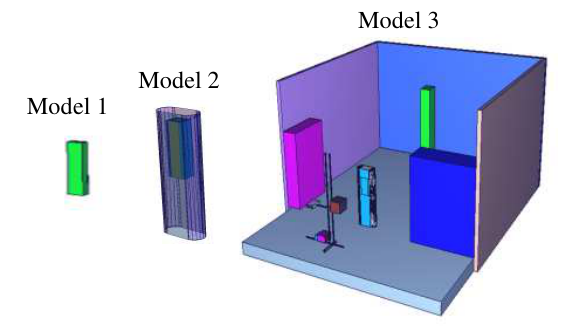
Fig.2. Tested models of the SRPM. A pulse height distribution estimate (F8 tally), was used to obtain the deposited energy distribution per incident photon in the detector volume. A comparison between empirical spectrum and MCNP6 simulated spectra of the NaI(Tl) detector in the case of a Eu-152 source is shown in Fig. 3.